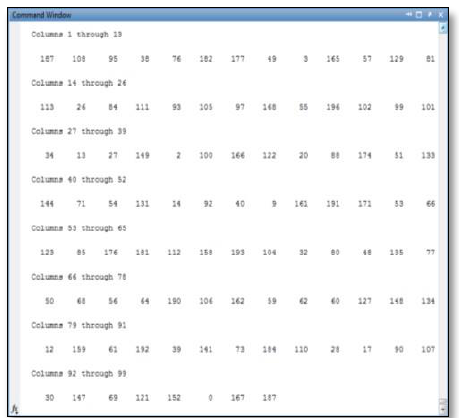
Figure 2 Output showing the first 99 elements in